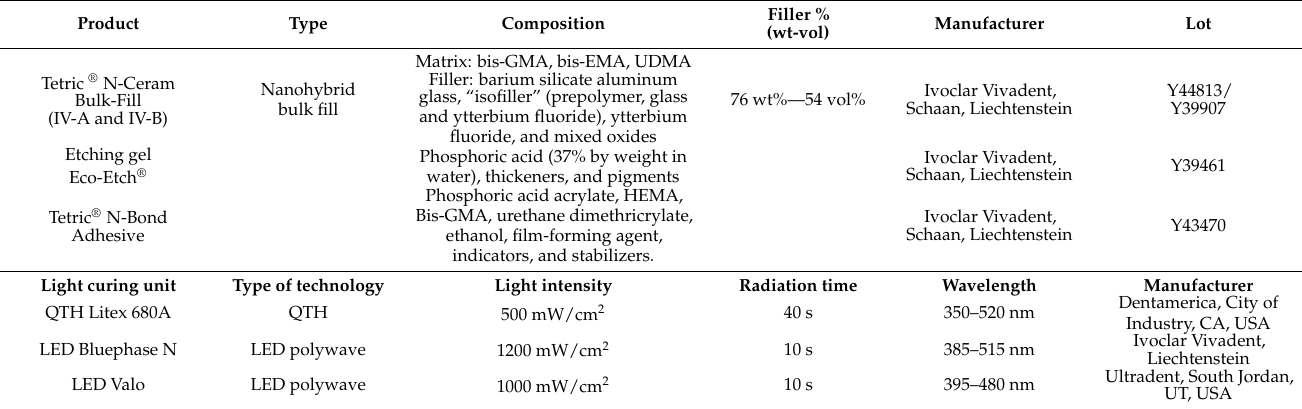
Table 1. Technical profile of products